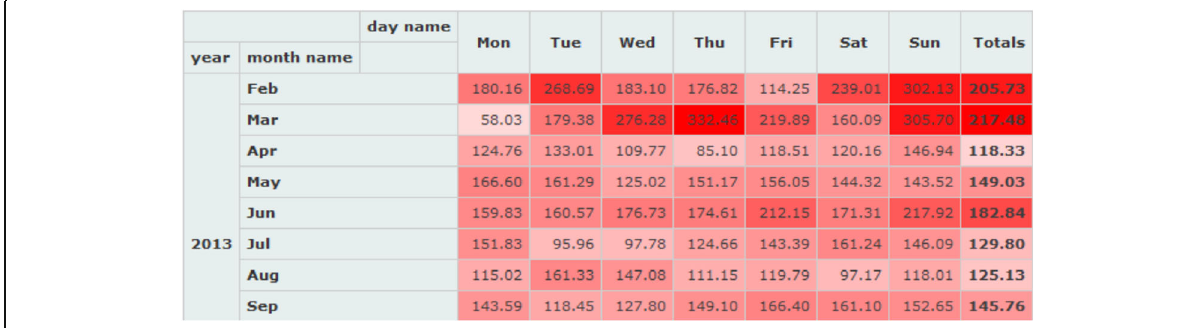
Fig. 1 Average PM2.5 air quality index of monthly and weekly hotlist in the traditional table